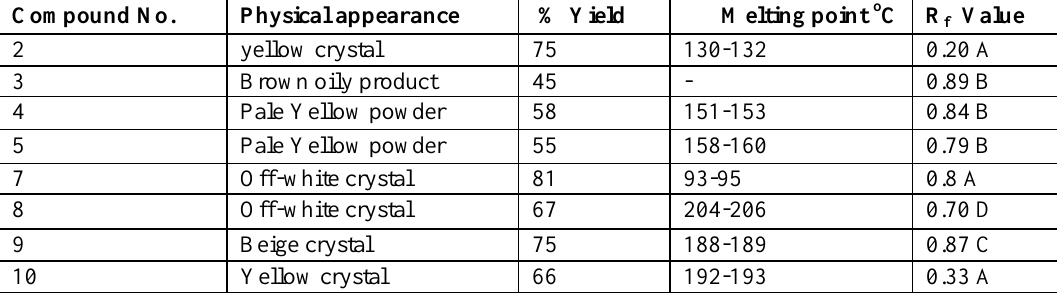
Table 1: Physical appearance, percentage yield, melting points and R and compounds. Compound No.